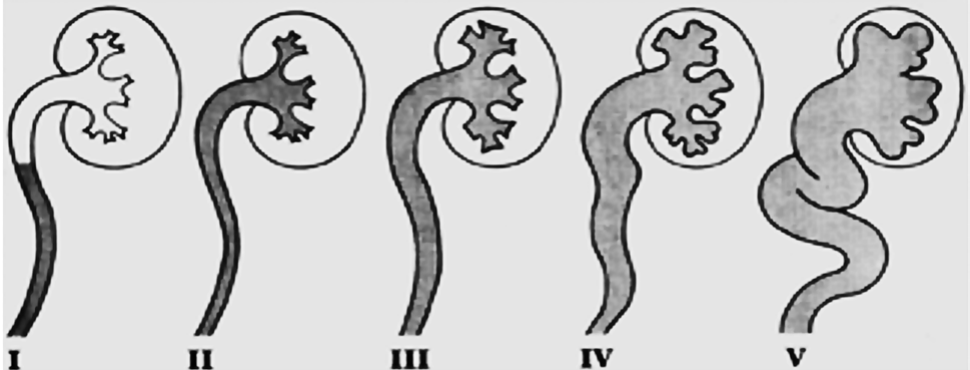
Figure 1 - International Classification of VUR.